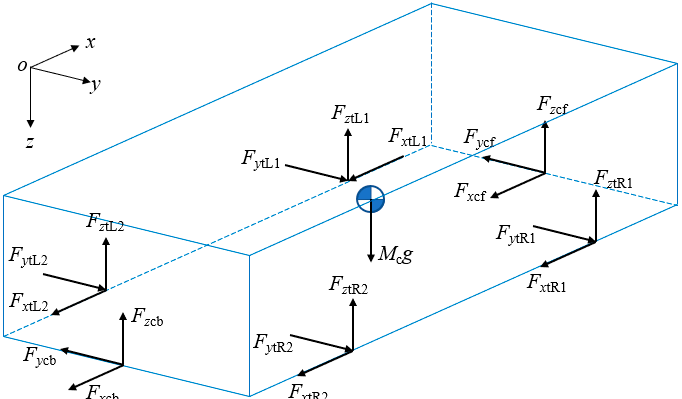
Figure 3. Force analysis of car body.